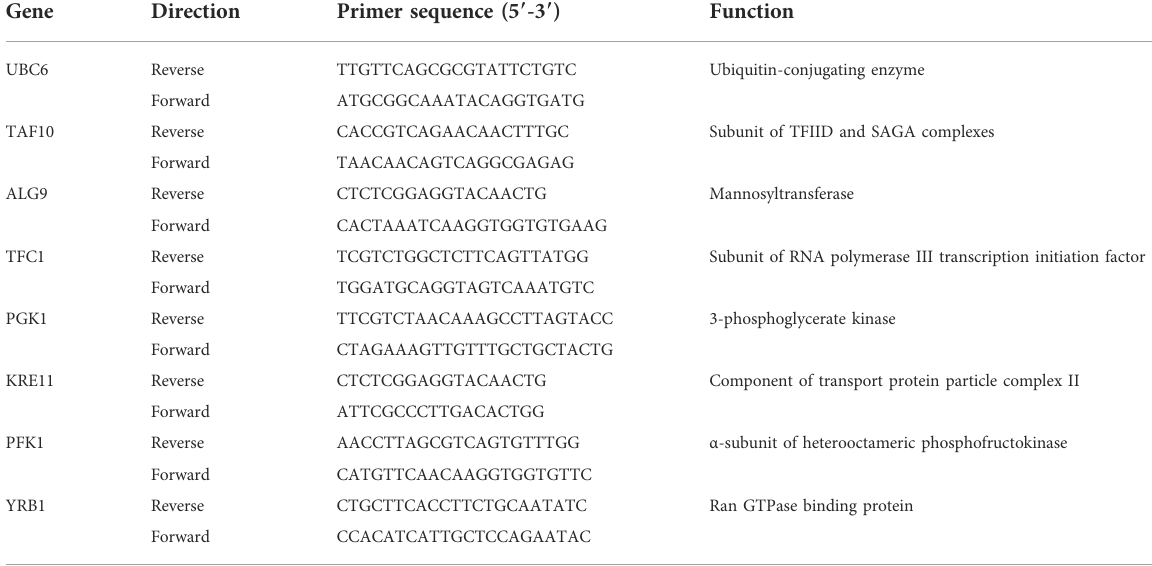
TABLE 2 Primer sets used for RT-qPCR ampli fi cation as possible reference genes.